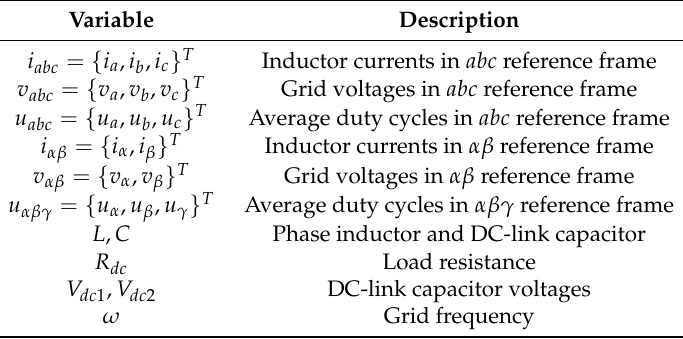
Figure 2. The three-phase three-level NPC converter topology. Table 1. System